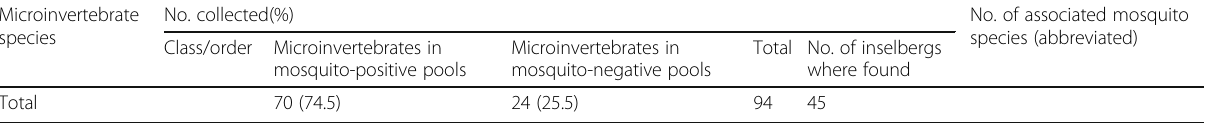
Table 2 Microinvertebrates coinhabiting mosquito habitats in rock pools on inselbergs within Kaduna State, Nigeria (Continued) Microinvertebrate